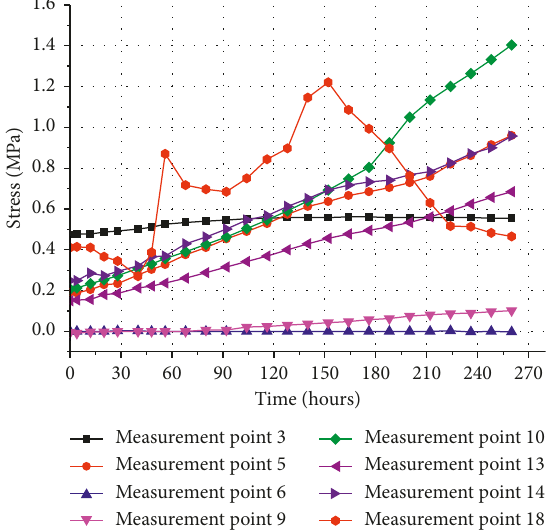
Figure 5: Surface subsidence caused by construction.